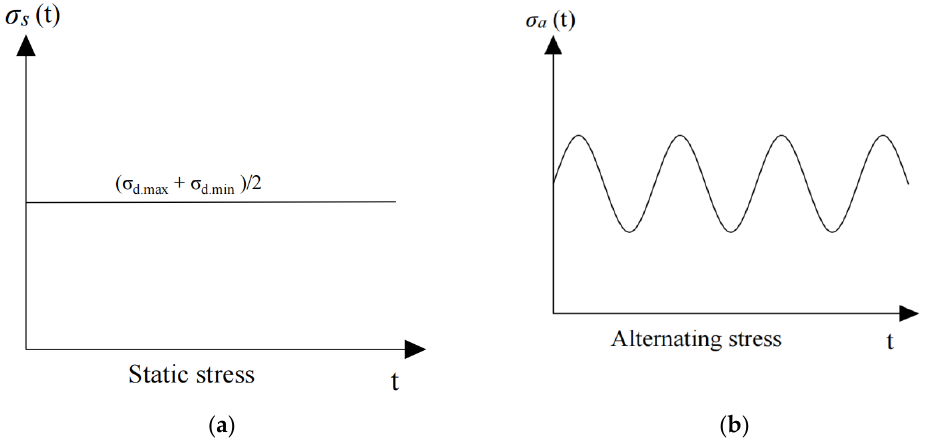
Figure 2. ( a ) Diagrammatic sketch of static stress; ( b ) Diagrammatic sketch of alternating stress. The static stress 𝜎 (cid:3046) (𝑡) and the alternating stress 𝜎 (cid:3028) (𝑡) in accordance with the above analysis can be expressed as